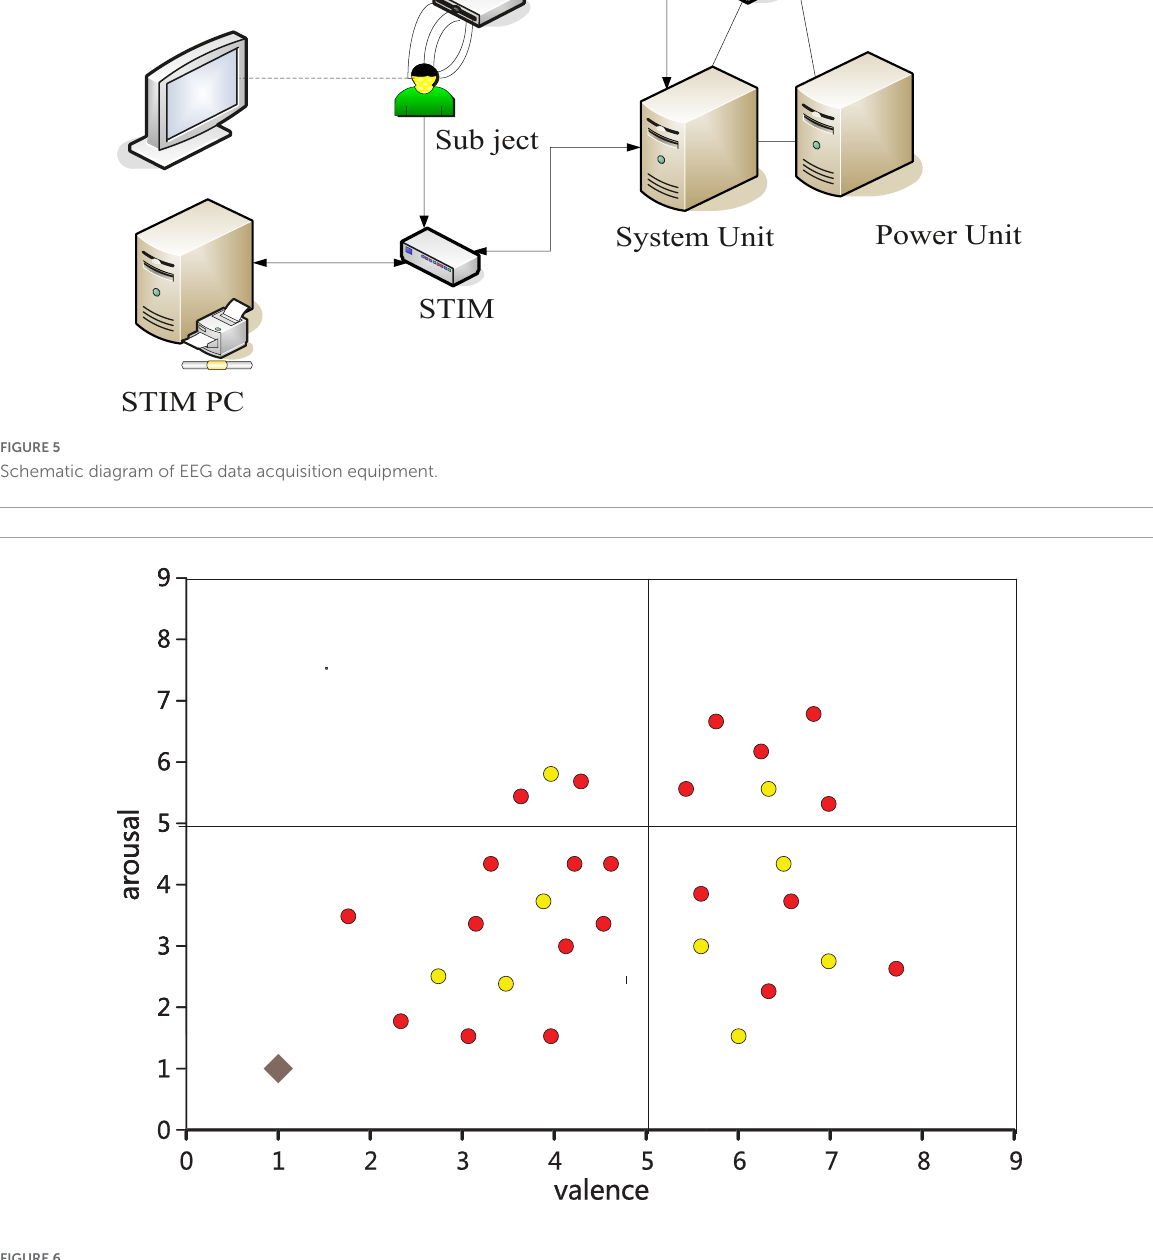
FIGURE6 Music sentiment distribution map in the database.